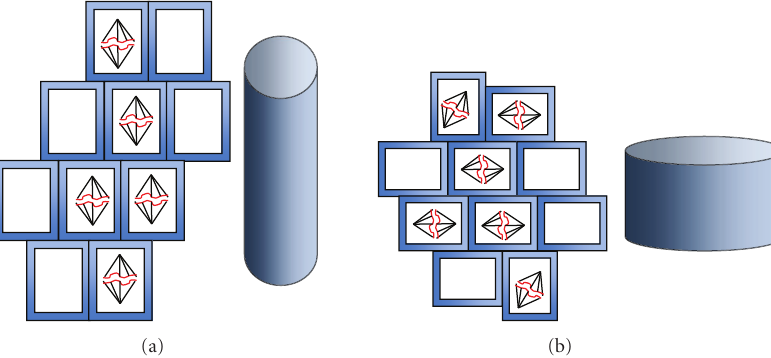
Figure 3: Defects in planar cell polarity results in cystogenesis. It is hypothesized that normal cilia function is required to control proper directional cell division. (a) Normal directional cell division is required to have an elongated tubular formation. (b) Disrupted directional cell division results in expanded formation of